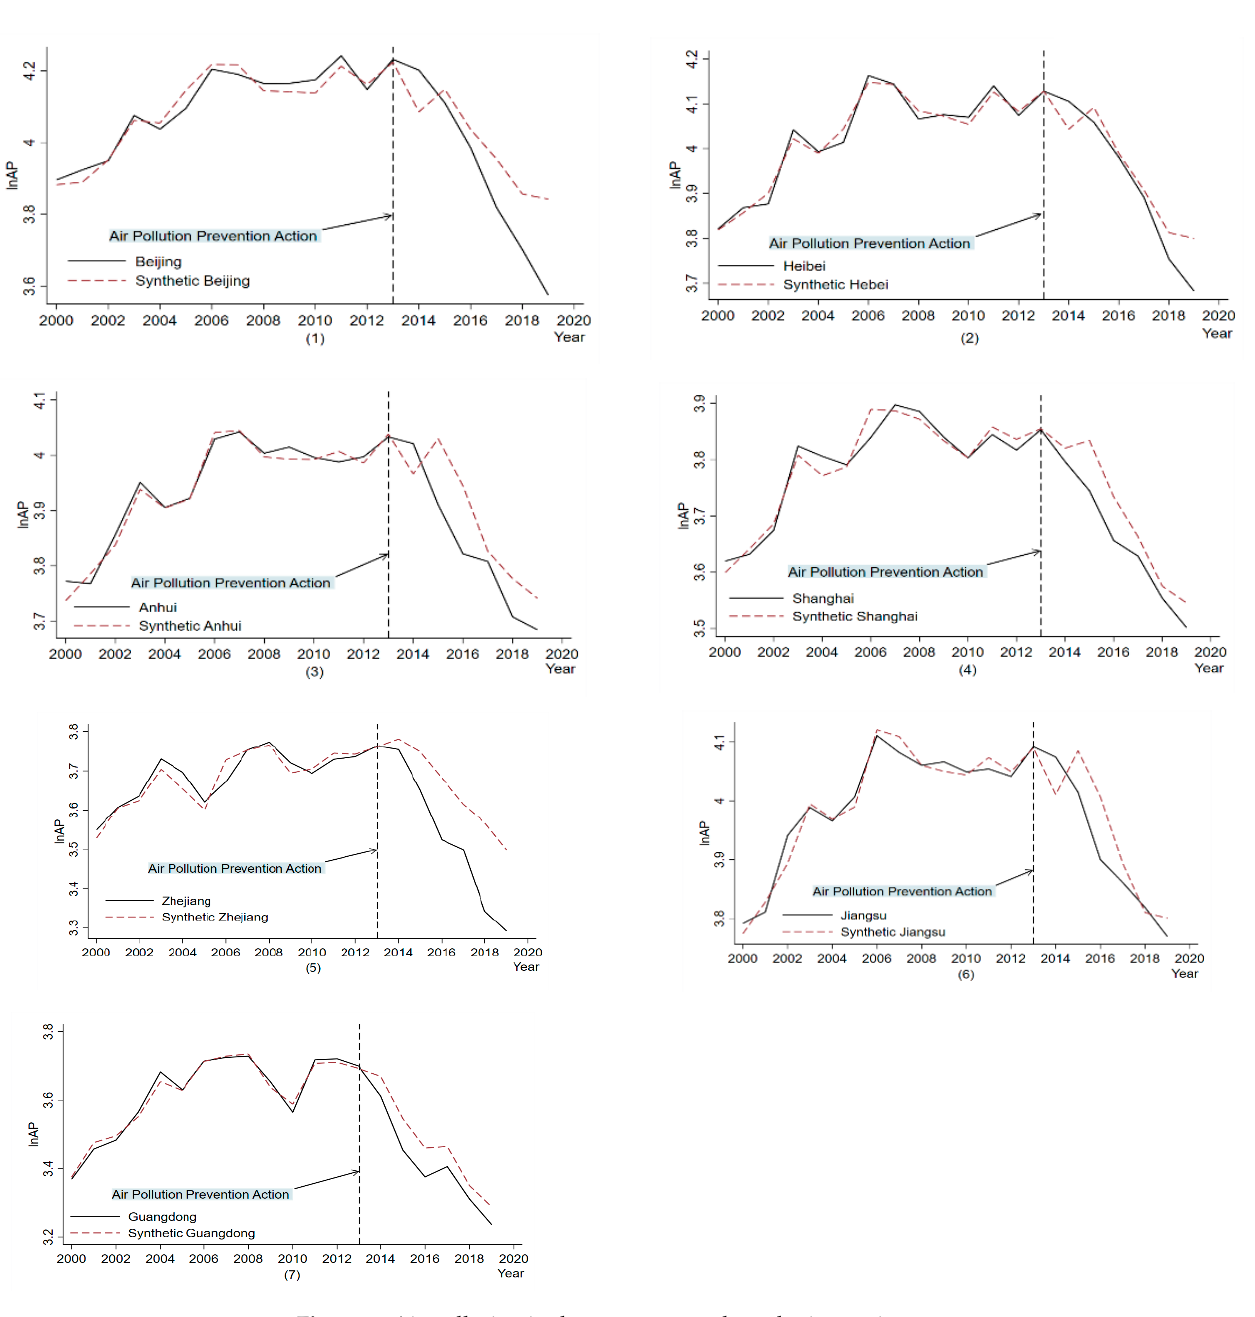
Figure 3. Air pollution in the treatment and synthetic provinces.